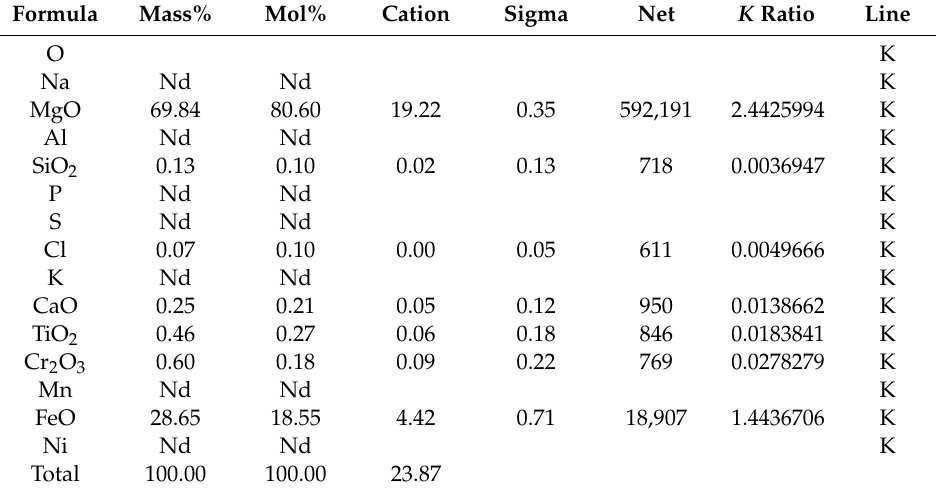
Table 2. The composition of samples after heat treatment and oxalic acid